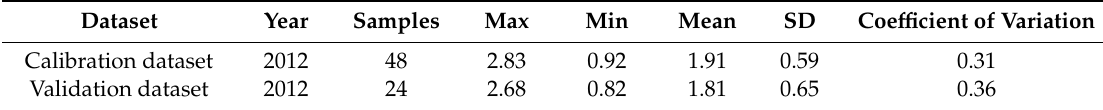
Table 1. Descriptive statistics of leaf nitrogen content